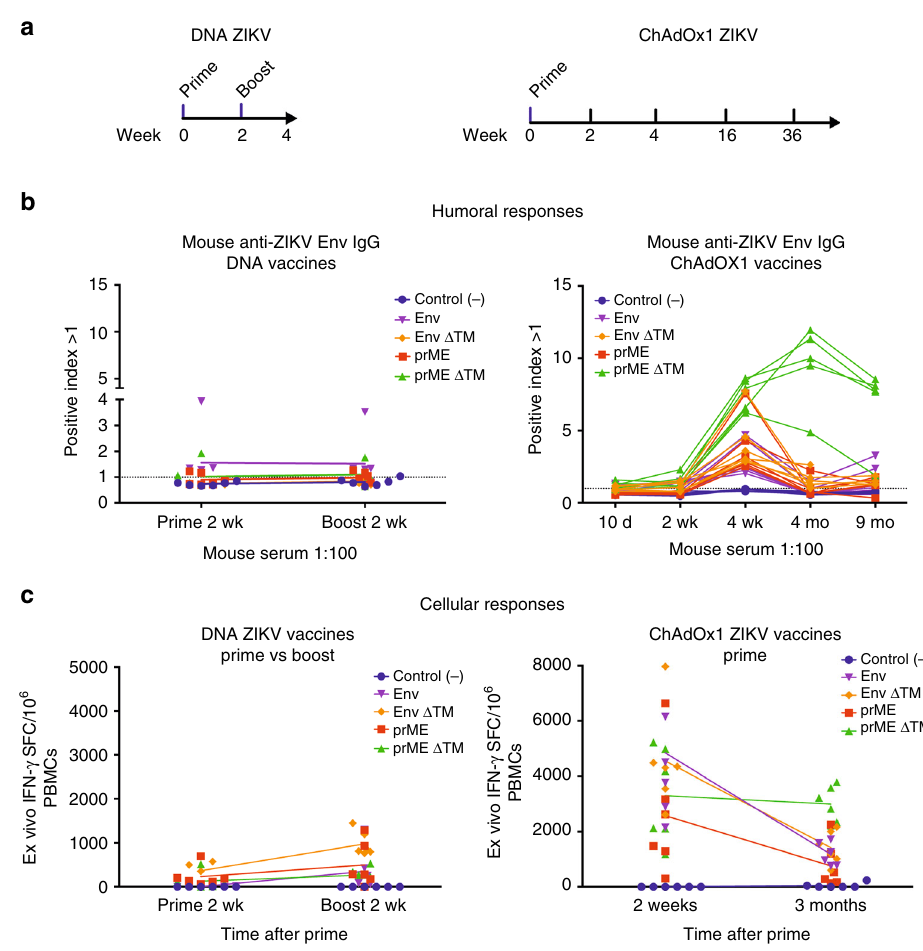
Fig. 2 Immune responses elicited by DNA versus ChAdOx1 vaccines. a For ZIKV DNA vaccines, BALB/c mice ( n = 6/group) were immunised intramuscularly (i.m.) with a dose of 100 μ g/mouse, followed by a DNA Boost 2 weeks thereafter. For ChAdOx1 ZIKV vaccines, a single dose of 10 8 IU/mice was i.m. administered. Blood samples were obtained at several time points for either ELISA or ELISPOT assay. b Humoral responses elicited by DNA Prime and Prime-Boost after 2 weeks (left) and by a single immunisation of ChAdOx1 ZIKV vaccines at 10 days, and 2, 4, 16 and 36 weeks (right). Antibody responses were quanti fi ed by ELISA with plates coated with ZIKV envelope protein. Positive index was calculated as depicted by ELISA kit manufacturers. c PBMCs – IFN γ -producing cells from DNA Prime-Boost after 2 weeks (left) and ChAdOx1 ZIKV vaccines at 2 weeks and 3 months after single immunisation were quanti fi ed by ELISPOT. 20-mer peptides spanning the ZIKV envelope protein (10 μ g/ml) were used for stimulation. Line colours and shapes represent mice vaccinated with each vaccine. Antibody production by ELISA and cellular responses by ELISPOT were replicated three times in the laboratory. A positive control sample was included to validate the ELISA